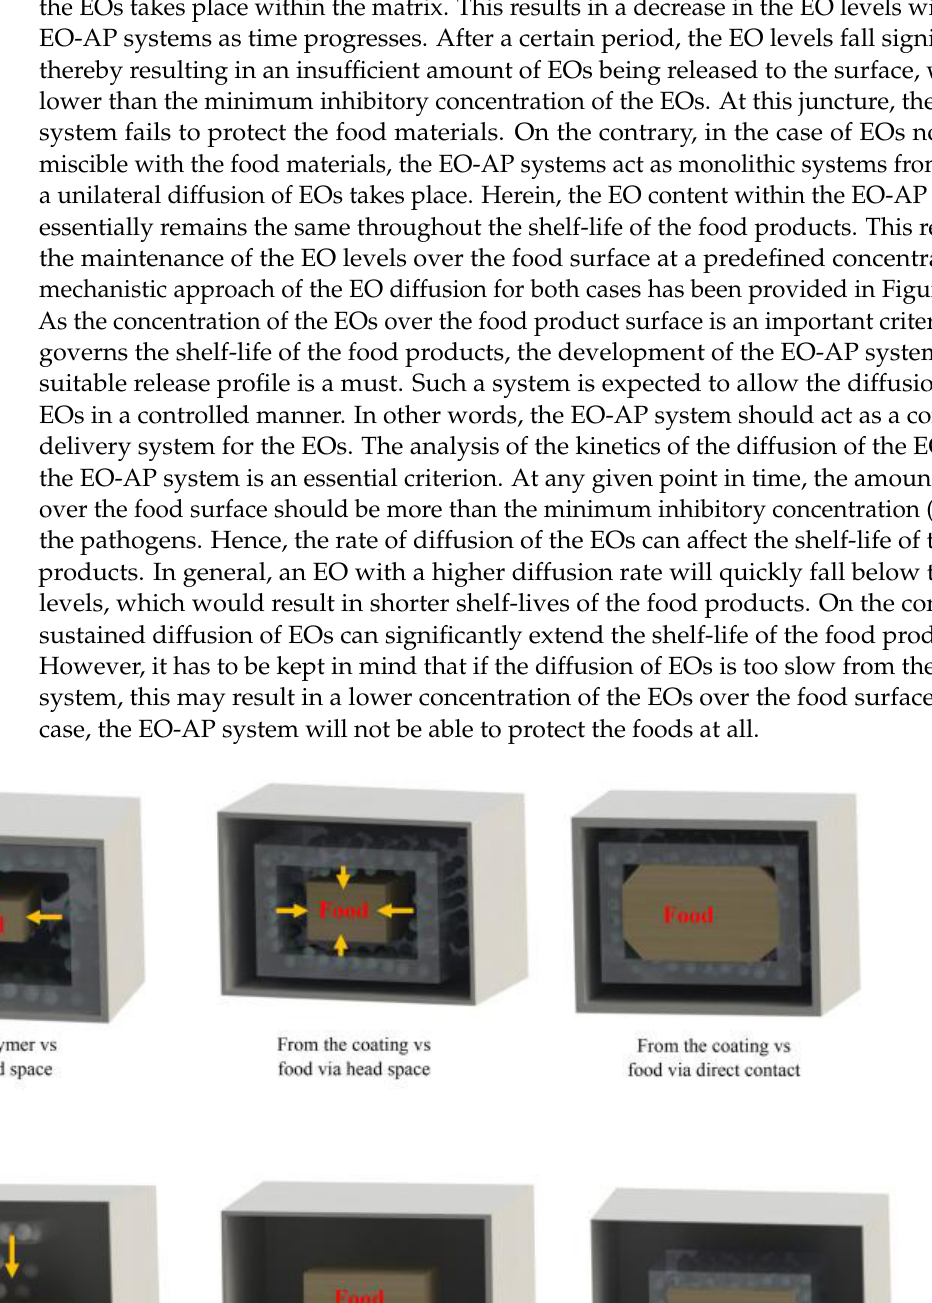
Figure 13. The migration curve of antimicrobial agents. ( A ) Release of soluble antimicrobial agents through free diffusion; ( B ): release of antimicrobial agents from monolithic system. Reproduced with permission from [5]. (Copyright 2019 Else- vier).